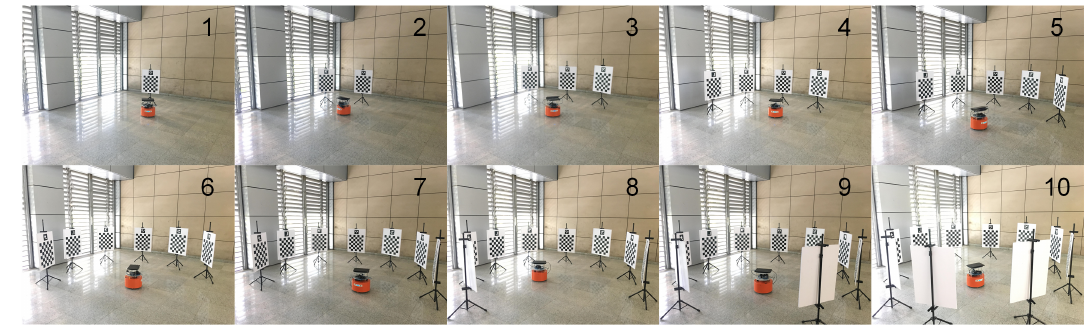
Figure 12. Experimental setup to test the effect of the number of the targets on calibration